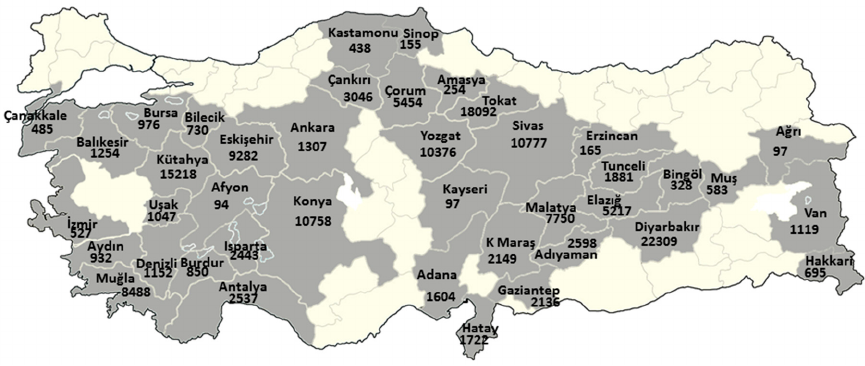
Figure 2. Population living in rural areas, where there is still asbestos exposure ongoing.